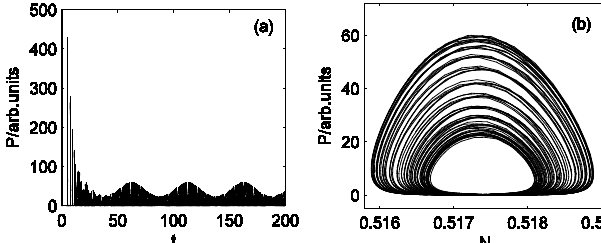
Fig. 1. Beating. (a) output. (b) an orbit in phase space.